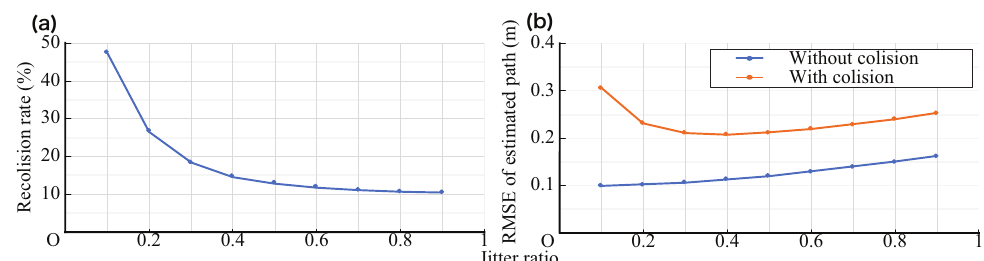
Figure 15. ( a ) Re-collision rate vs. jitter ratio J ( N = 2, T = 1 s). ( b ) RMSE of estimated path vs. jitter ratio ( N = 2, T = 1 s).